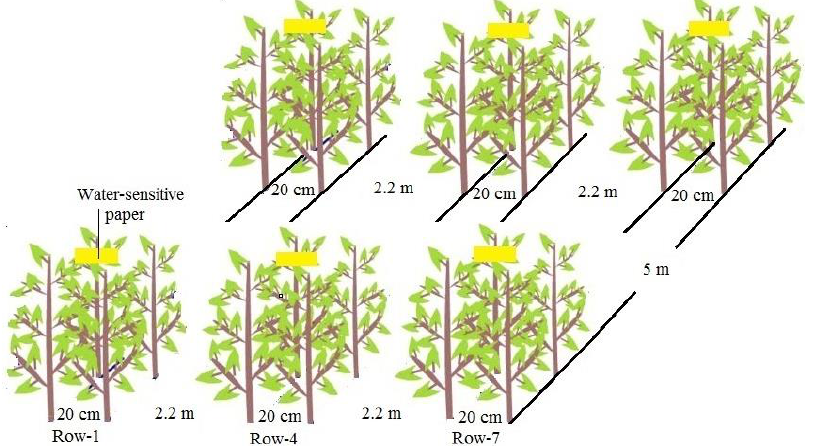
Figure 3. Experimental plan for each plot.